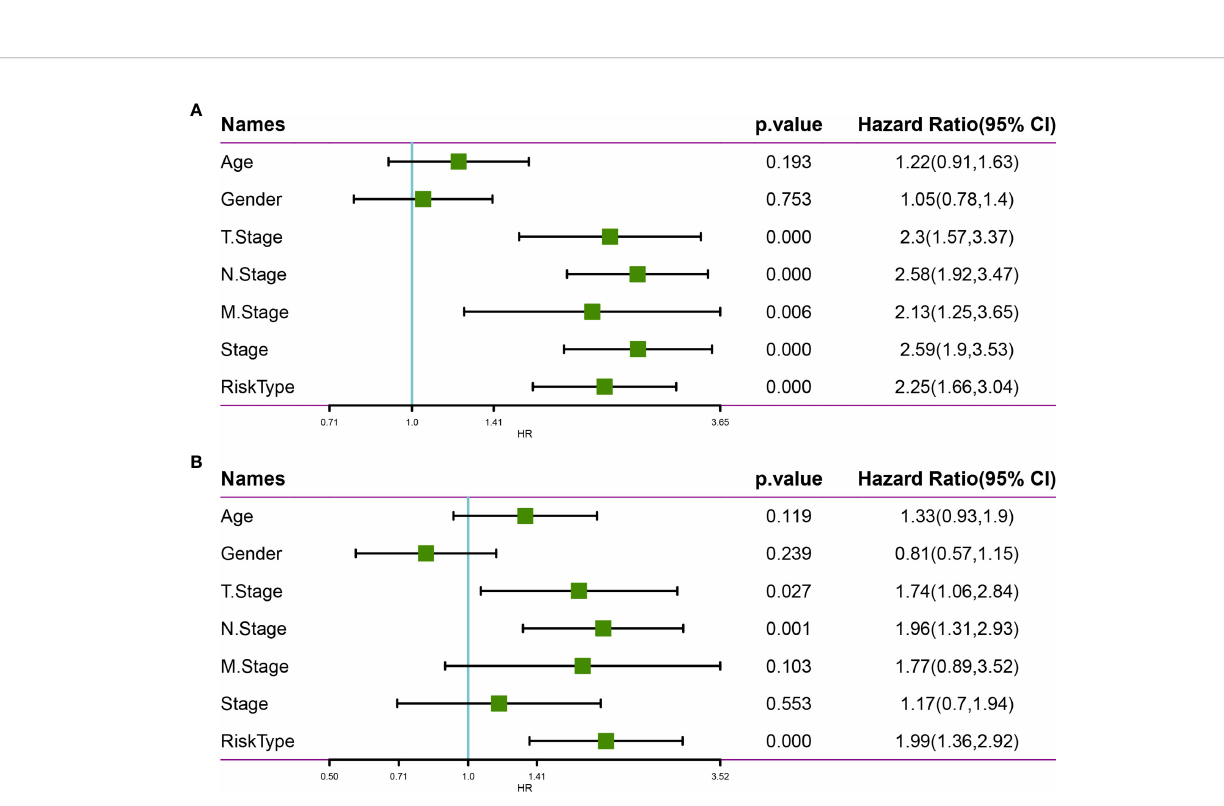
FIGURE 12 | Univariate and multivariate analysis of the risk model based on the 10-gene signature using the TCGA-LUAD dataset. (A) Univariate Cox regression analysis. (B) Multivariate Cox regression